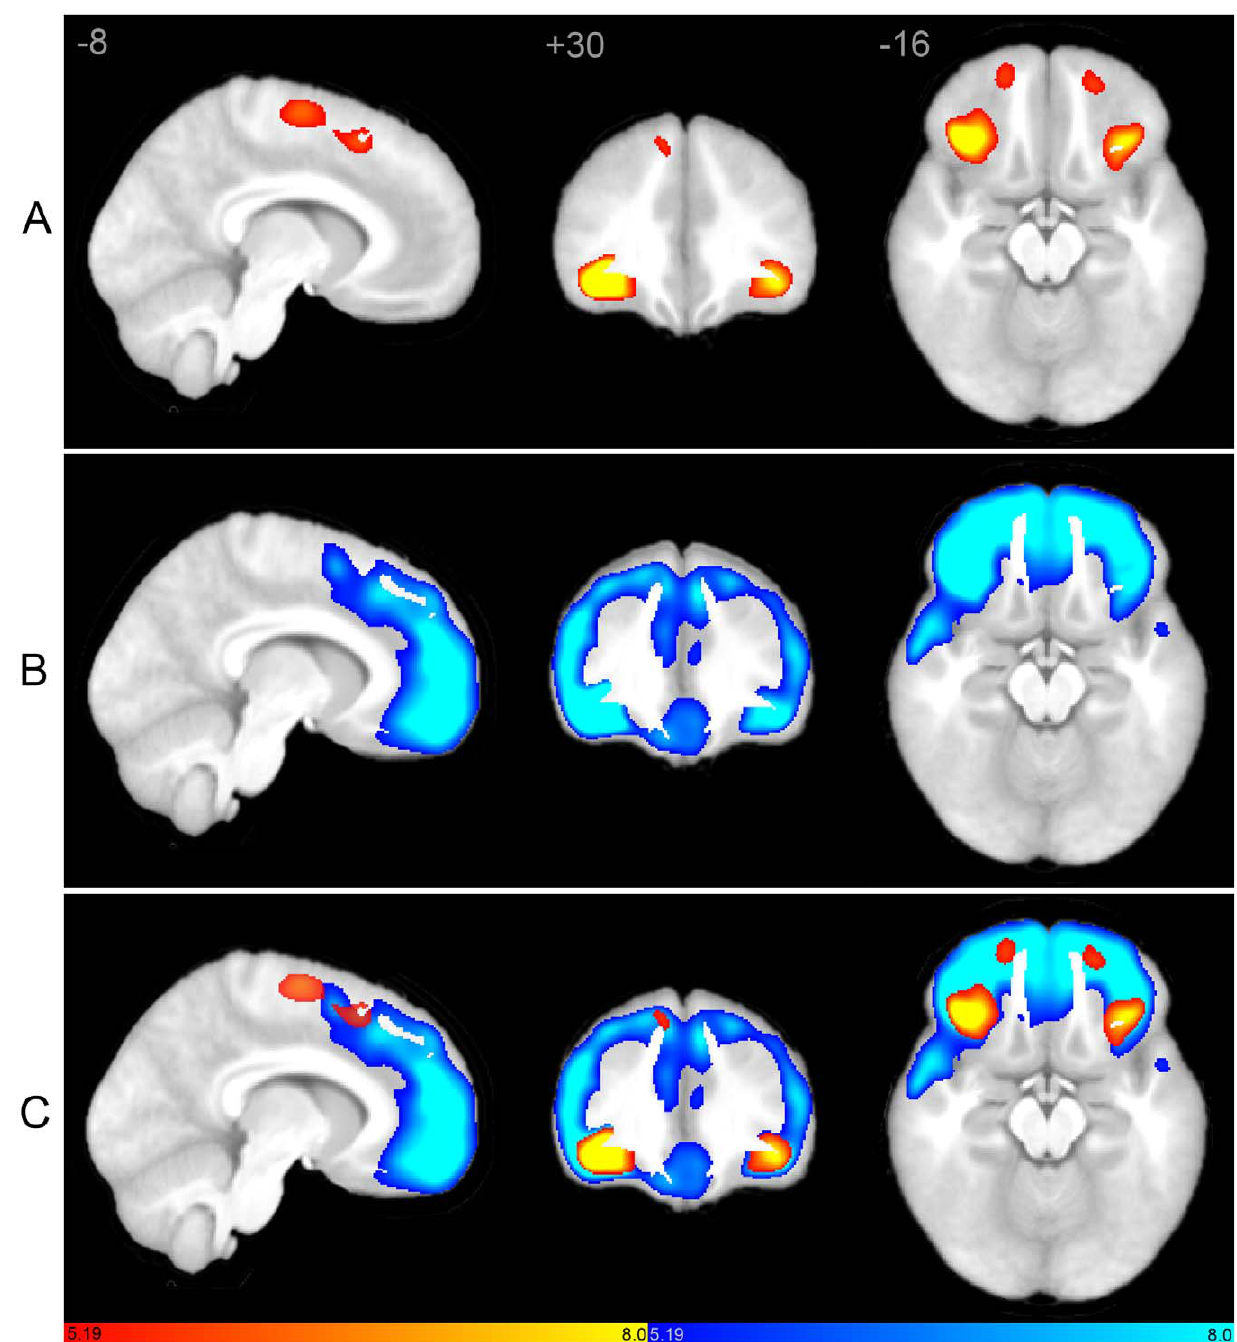
Figure 1. Structural covariance maps of the salience network in autism and controls. Statistical parametric maps depict brain regions in which gray matter intensity covaried with that of the seed ROI (right FI) in each group. (A) Structural covariance patterns appear substantially spatially restricted in autism (hot colors; see also Table 2). (B) Corresponding scMRI map in normal controls corresponds to a robust canonical SN (cool colors). (C) scMRI maps from both groups overlaid on a single anatomic volume. scMRI data are T-statistic maps (p , 0.01, FWE-corrected) displayed on the average anatomical template of all subjects. The left side of the image corresponds to the right side of the brain. FI, frontoinsula; FWE, family-wise error; ROI, region of interest; scMRI, structural covariance MRI; SN, salience network. doi:10.1371/journal.pone.0049172.g001 group that extended more posteriorly versus the control group. Default Mode Network Peak clusters and coordinates are depicted in Table 2. In controls, the right PCC seed covaried with bilateral precuneus/retrosplenial cortex, lateral parietal regions including angular gyrus, right medial prefrontal cortex, and discrete nodes